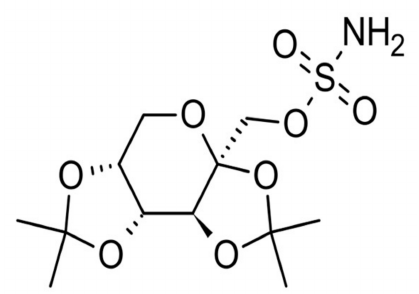
Figure 1. Molecular structure of topiramate.